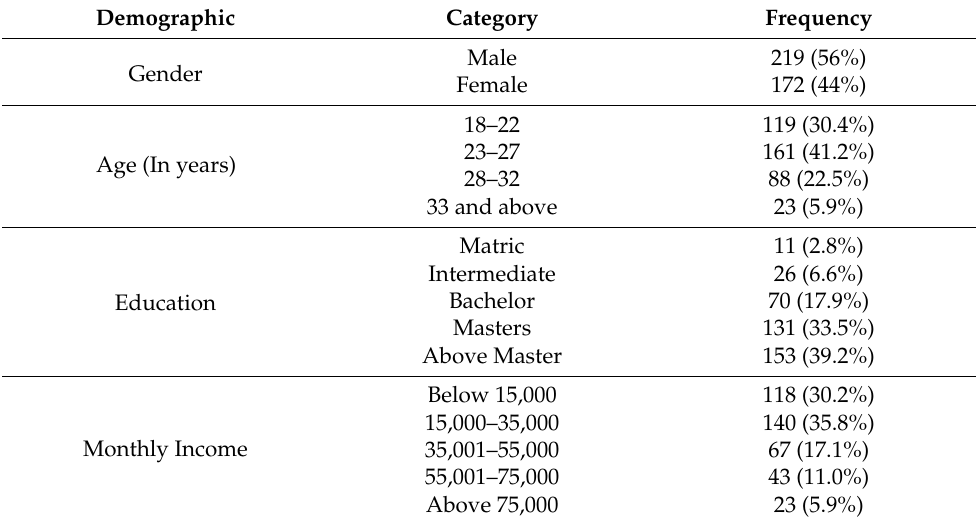
Table 1. Demographic Variable Profile.